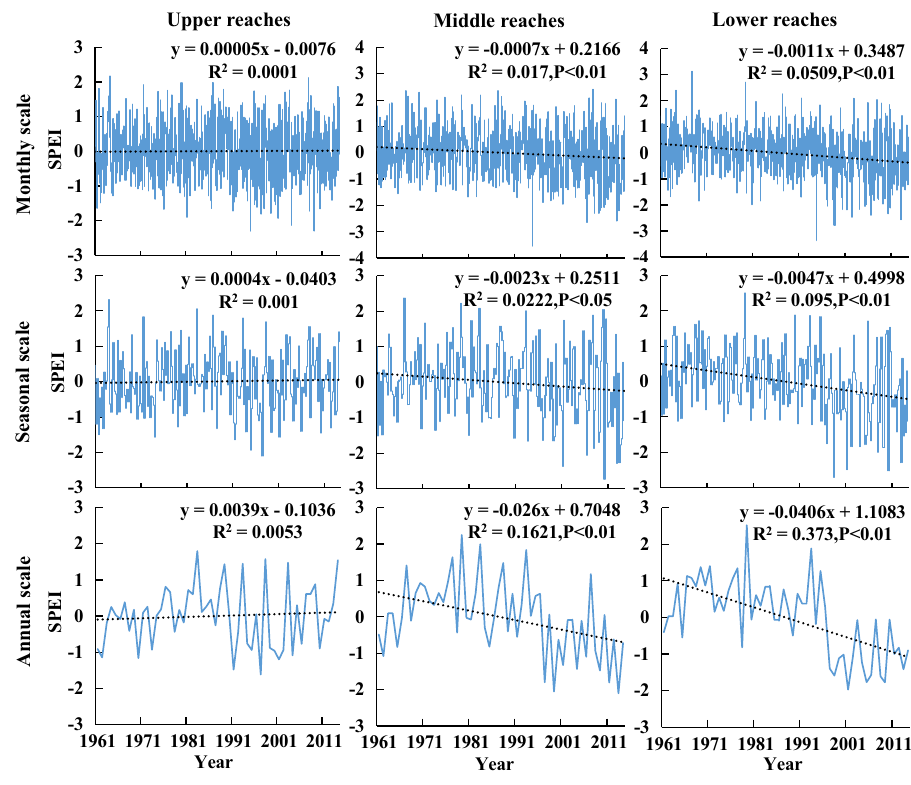
HRB. The statistical values are listed in Table 2. The SPEI series in the upper reaches represent upward trends with no significant difference. The seasonal scale SPEI in the middle reaches is significant at the 0.1 probability level, and the other sequences are significant at the 0.01 proba- bility level, which illustrates that droughts in the middle and lower reaches show a significant downward trend during 1961–2014.